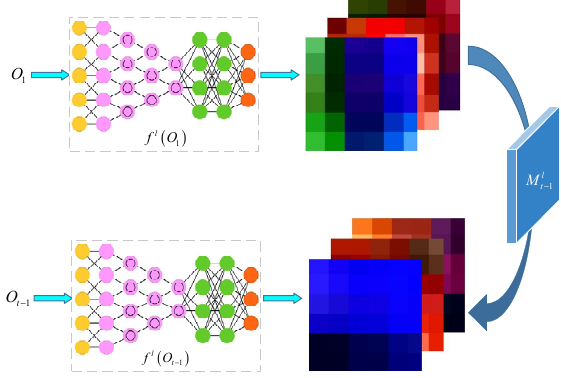
Figure 2. Conversion of the target appearance change.